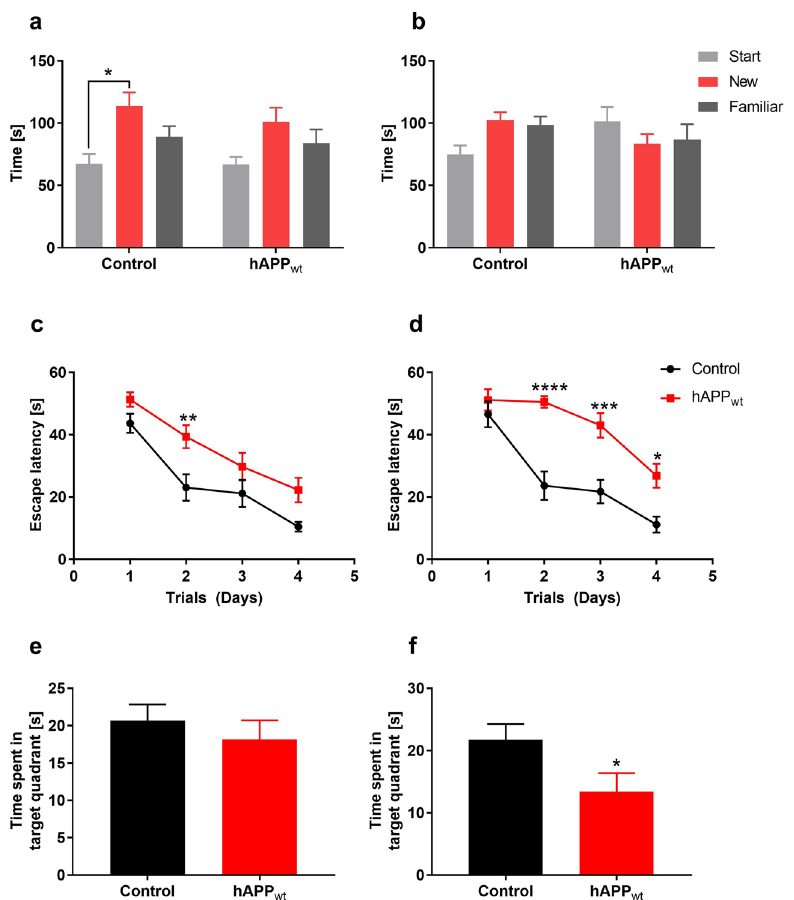
Figure 2. Performance of 6 month and 12 month old male hAPP wt and control animals in behavioral tasks. ( a ) Recorded exploration time of the start, new and familiar arm of the modified Y-maze in 6 month old hAPP wt (n = 16) vs. control (n = 12) mice and ( b ) in 12 month old hAPP wt (n = 8) and control (n = 12) animals. ( c ) Recorded escape latency in the Morris water maze (MWM) compared between 6 month old hAPP wt (n = 16) and control (n = 12) animals as well as ( d ) 12 month old hAPP wt (n = 8) and control (n = 12) mice. ( e ) Recorded time spent in the target quadrant of the MWM during probe test (platform removed) of 6 month old hAPP wt (n = 16) and control (n = 12) animals and ( f ) 12 month old hAPP wt (n = 8) and control (n = 12) mice. (Values are means ± SEM; *P ≤ 0.05, **P ≤ 0.01, ***P ≤ 0.001, ****P ≤ 0.0001, two-way ANOVA with Sidak’s post-hoc test for a–d , two-tailed unpaired t-test for e/f